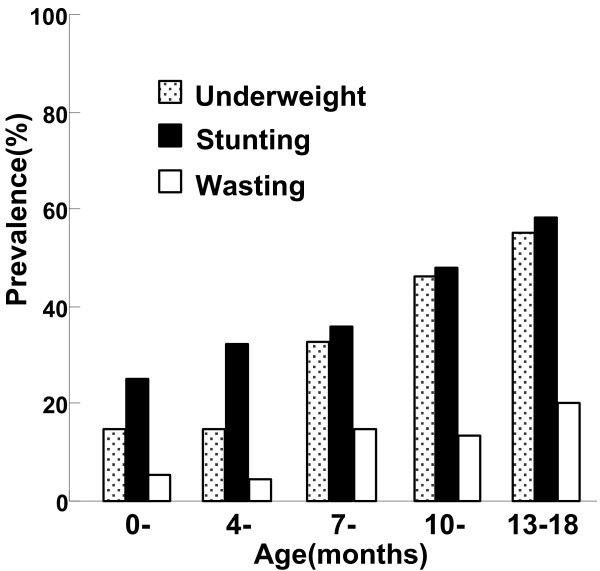
Prevalence of malnutrition* among 0–18 month-old infants in rural Shaanxi province, China, 2010. *Malnutrition includes underweigtht, stunting and wasting. Underweight: WAZ < 2 standard deviations than the mean; Stunting: HAZ < 2 standard deviations than the mean; Wasting: WHZ < 2 standard deviations than the mean [WHO, 2006].